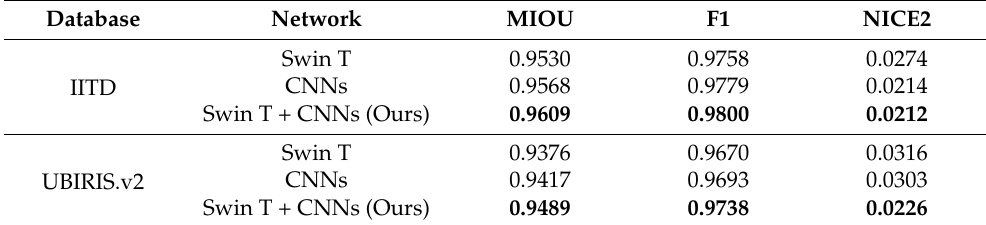
Table 3. Results of network ablation